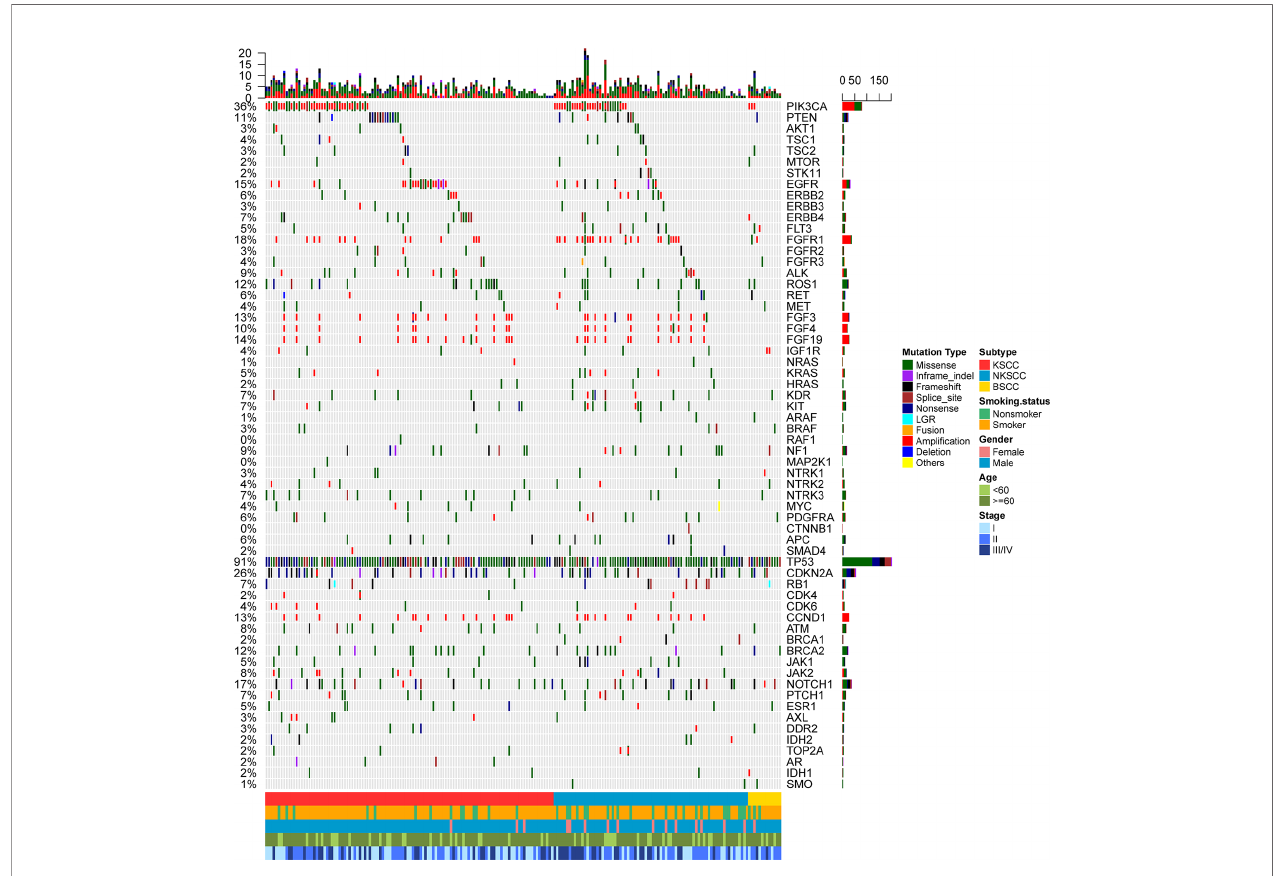
FIGURE 1 | Mutational spectrum of the LUSC patients grouped according to histological subtypes. Smoking status, gender, age, and disease stage were also annotated at the bottom of the oncoprint. Each column represents a patient and each row represents a gene. Column on the left represents the mutation rate of each gene. Column on the right represents mutated genes. Top plot represents the overall number of mutations a patient carried. Different colors denote different types of mutation. KSCC, keratinizing squamous cell carcinoma; NKSCC, non-keratinizing squamous cell carcinoma; BSCC, basaloid squamous cell